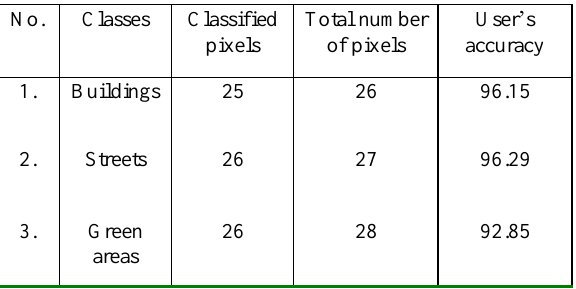
Table 10 . User’s accuracy for the image from 2017 • Producer’s accuracy is calculating by reviewing the sites for correct classifications and dividing them by the total number of reference sites for each class (Table 11, Table 12).